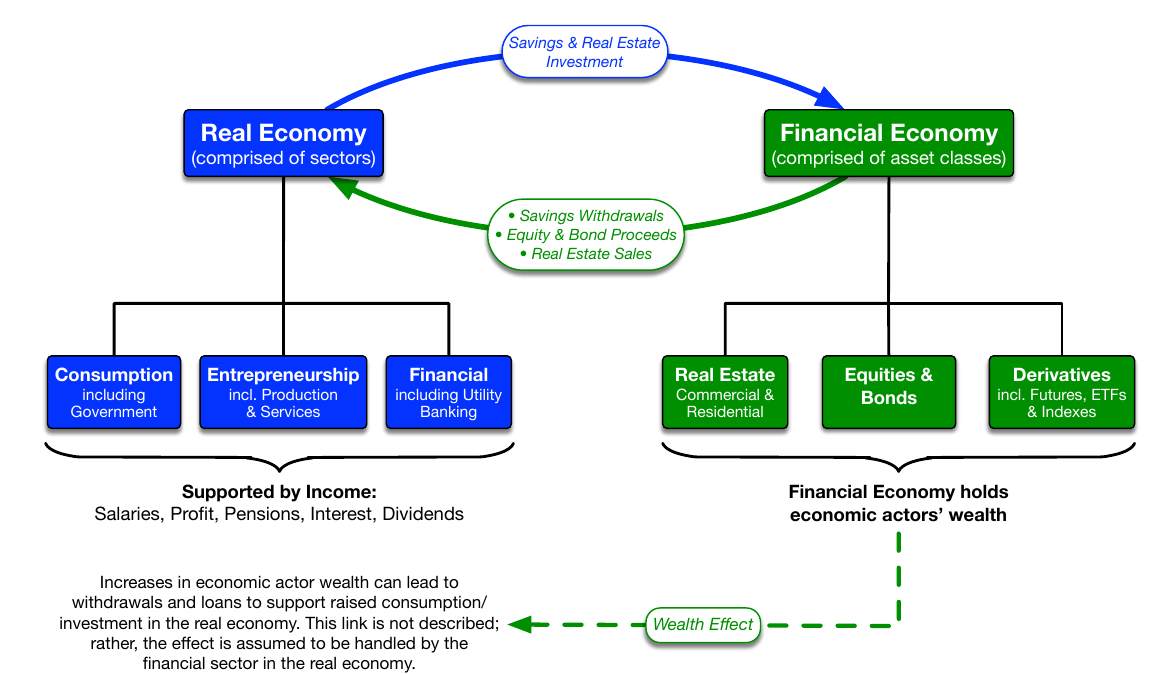
Figure 12. Structure of the two economies, high-level monetary flow connections, and wealth